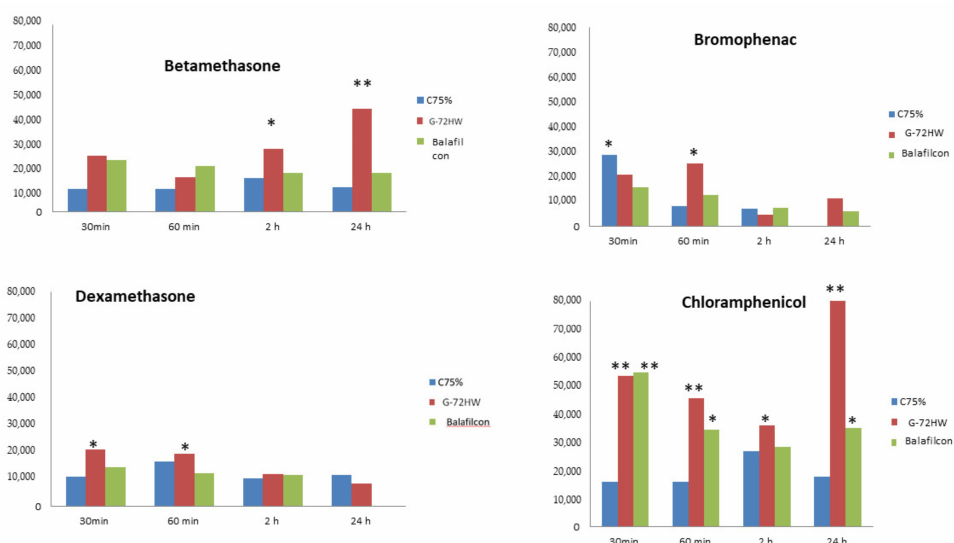
Figure 3. The horizontal axis indicates the time elapsed since the application of the drugs to the lenses. The vertical axis indicates the amounts of drugs eluted through the lenses at each time point, expressed as absorbance units evaluated at drug-specific wavelengths at drug-specific retention times. * p < 0.05; ** p < 0.01 vs. other lenses as detailed in the text; * p = 0.05 C75% vs. Balafilcon A.